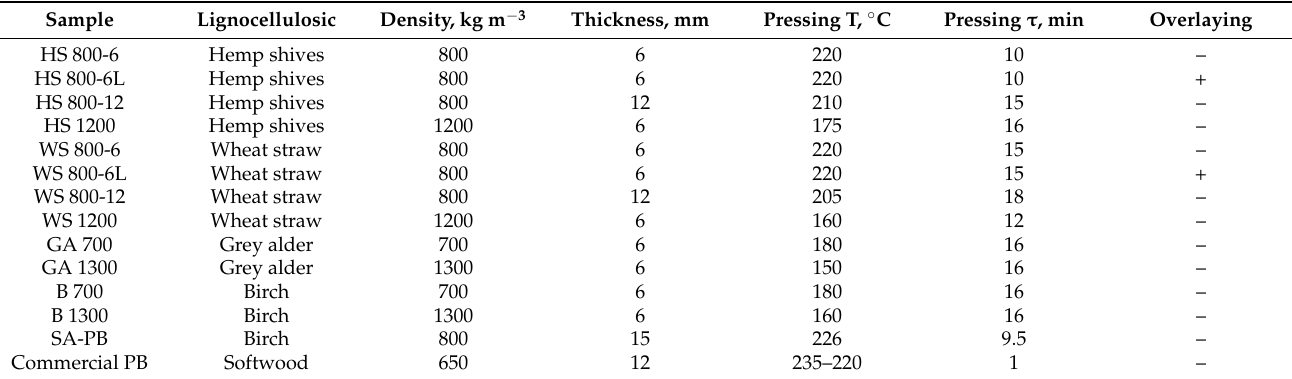
Table 1. Designation and fabrication conditions of board samples provided for VOCs